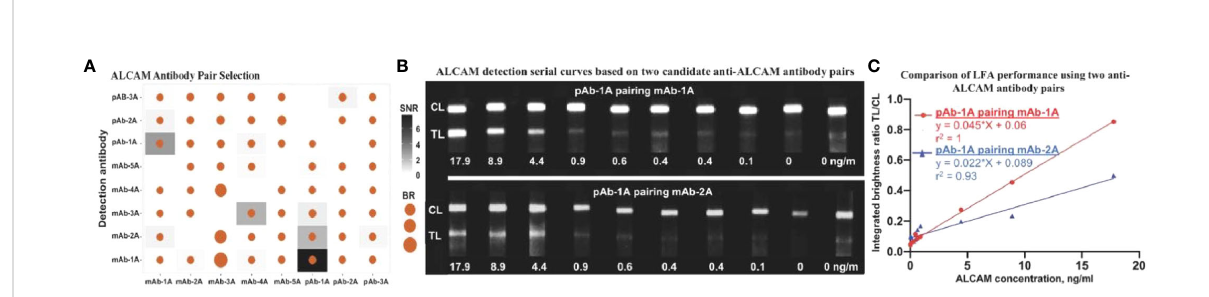
FIGURE 1 Antibody pair selection for construction of ALCAM LFA. (A) 57 antibody pairs (eight types of antibodies were tested in all combinations and with each serving as detection Ab-the antibody conjugated onto the nanophosphors and as capture Ab-the antibody immobilized onto the LFA strip) were tested for ALCAM LFA performance, of which two pairs showed relatively high SNR and brightness ratio. (B) Serial curve of nanophosphor- based LFA were constructed for ALCAM detection in buffer. Each concentration point was singularly tested except for negative controls (0 ng/ ml) in duplicate. These grayscale images were collected using a FluorChem gel documentation and were analyzed using ImageJ. (C) Integrated brightness ratio (TL/CL) as a function of ALCAM concentration showed that pAb-1A as capture antibody and mAb-1A as detection antibody achieved the highest LFA performance with high linearity (r 2 ) of 1. The positive (17.9 ng/ml) and negative (0 ng/ml) buffer under both candidate antibody pairs were tested twice before constructing the standard curves. SNR, signal-to-noise ratio (In a given antibody pair, the integrated brightness at the TL of that positive LFA strip over the integrated brightness at the TL of that negative strip with no analyte).; BR, Brightness ratio (the integrated brightness intensity of TL over that of CL); TL, test line; C,: control line; pAb-1A, polyclonal anti-ALCAM antibody from